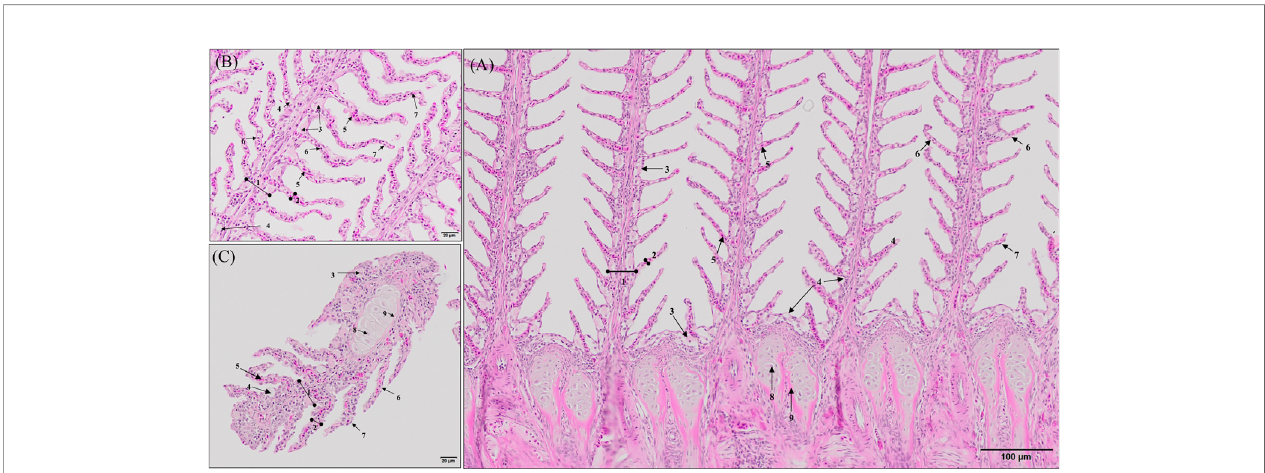
FIGURE 2 | General morphology of European sea bass ( Dicentrarchus labrax ) gill. (A, B) Representative micrograph of a longitudinal section of the central segment corresponding to the second right holobranch. (Hematoxilin – Eosin; Bar = 100 & 20 μm). (C) Representative micrograph of a transversal section in the middle part of the second right holobranch. (Hematoxilin – Eosin; Bar = 20 μm). (1) Primary lamella, (2) Secondary lamella, (3) Chloride cell, (4) Goblet cell, (5) Erythrocytes, (6) Pilar cell, (7) Epithelial cell, (8) Chondrocytes, (9) Extracellular cartilaginous